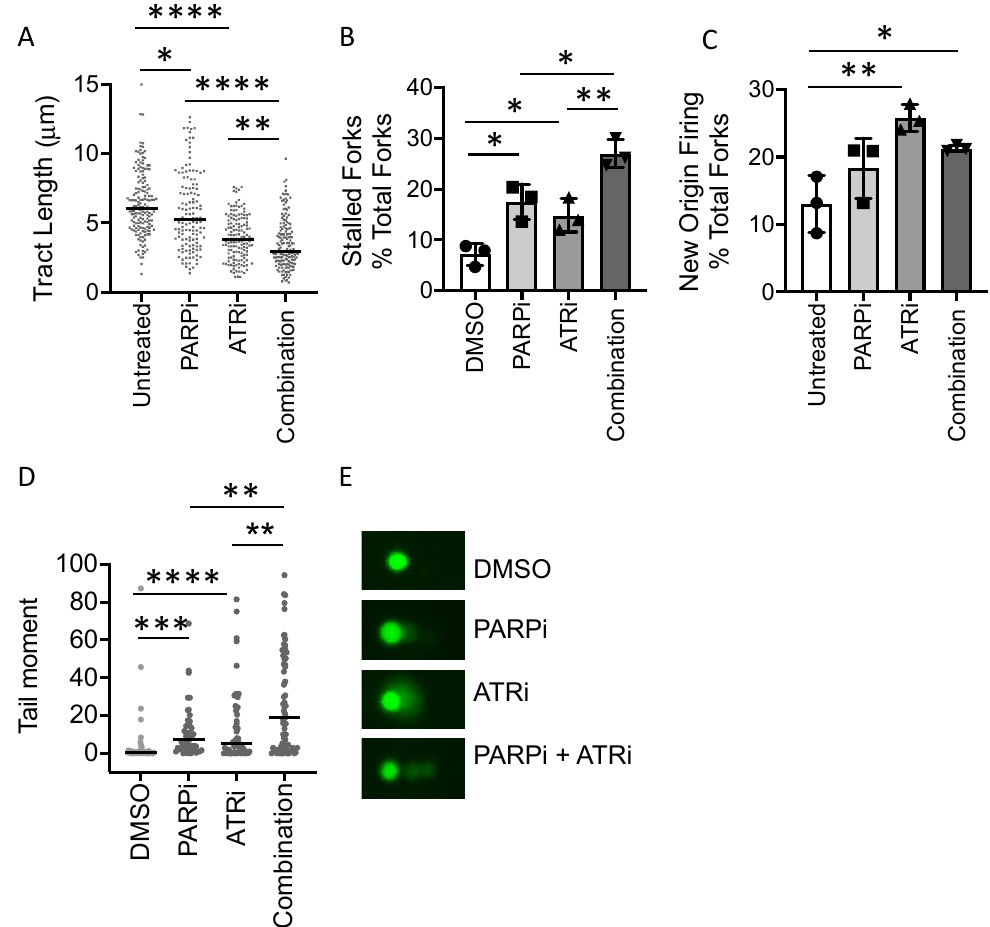
Figure 4. Co-treatment with PARP and ATR inhibitors increases replication stress and DNA damage . DNA fibre analysis of replication fork speed and stalling in VE-821/Olaparib treated SHEP-1 cells. Cells were incubated in 0.5 µM VE-821 and or 0.5 µM Olaparib or DMSO control and then pulse labelled with CldU, for 20 min, and label switched to IdU for 20 min. ( A ) DNA fibre length (µm) (CIdU), ( B ) Percentage fork stalling, calculated as a % of CIdU only labelled tracts (red) from continuous forks (CIdU (red) and IdU (green) labelled tracts) and ( C ) Percentage new origin firing, calculated as % of IdU only labelled tracts (green) from continuous forks (CIdU (red) and IdU (green) labelled tracts. For ( A – C ), at least 100 forks were counted on each of three separate occasions, ( A ) shows pooled data (means of individual repeats is shown in Supplementary Figure S4), ( B , C ) show means of 3 independent repeats. ( D ) DNA damage; alkaline COMET assay of VE-821/Olaparib treated SHEP-1 cells incubated in 0.5 µM VE-821 and or 0.5 µM Olaparib or DMSO control for 24 h. Tail moment was calculated using CometScore software where at least 50 cells were analysed on each of three occasions. Pooled data are shown (means of individual repeats are shown in Supple- mentary Figure S4). ( E ) Representative COMET assay images. Images were obtained using the full spectrum function of the CometScore software. Cells were originally stained with SYBR Safe DNA gel stain. Statistical significance was calculated using the Mann–Whitney U test (pooled data) and